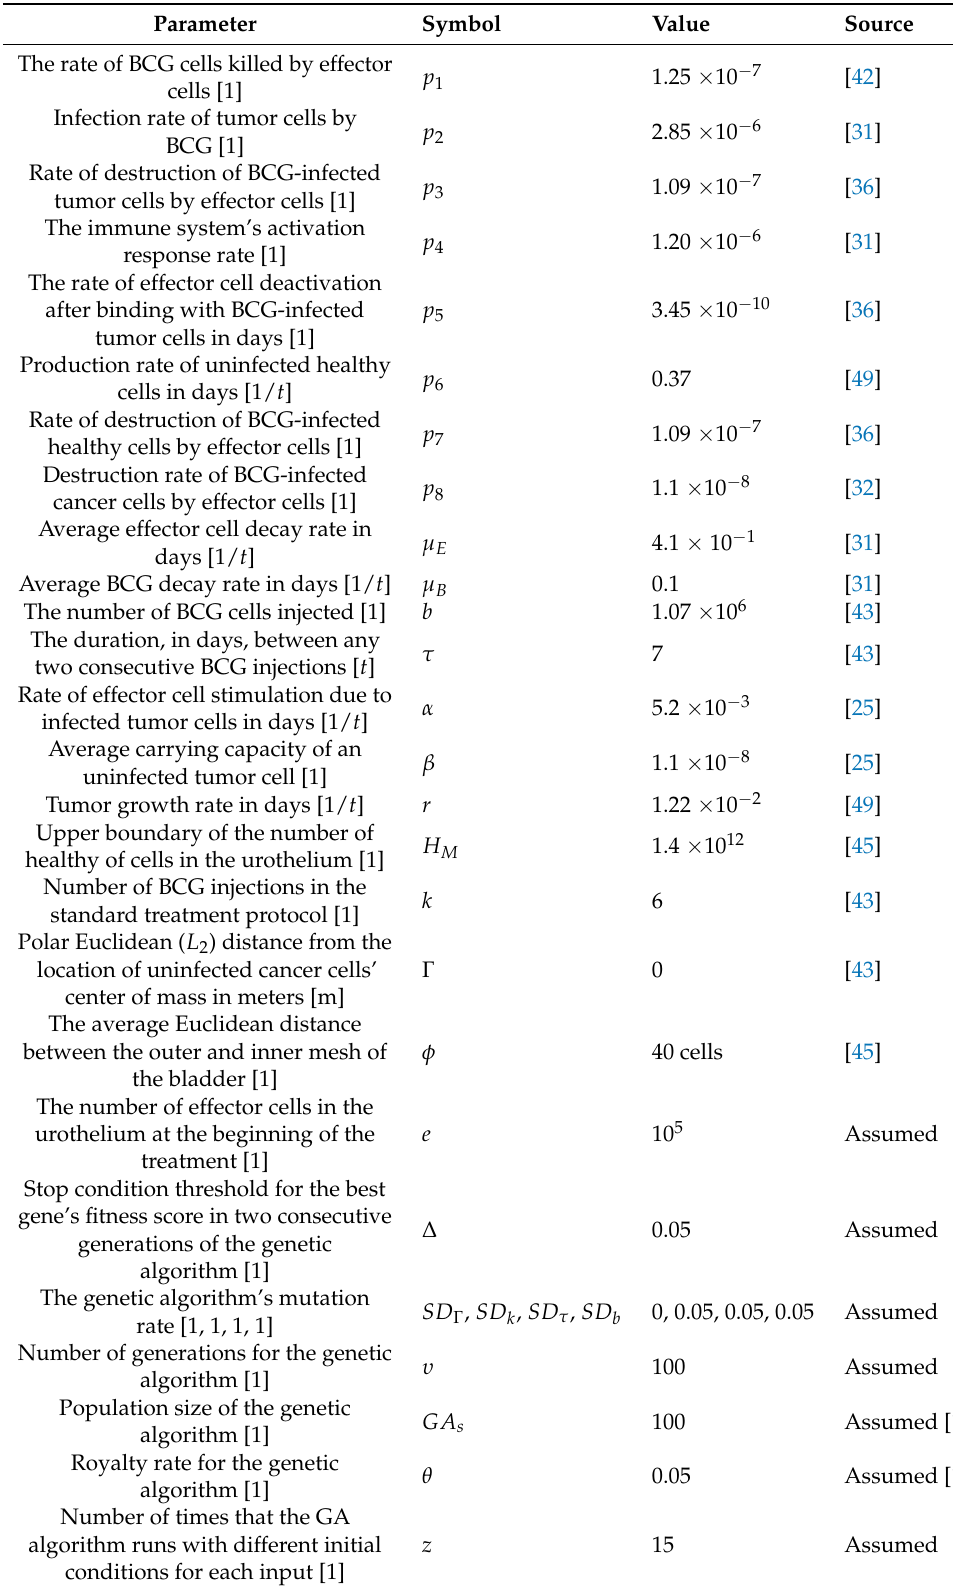
Table 1. The default values of the model’s parameters’ values and